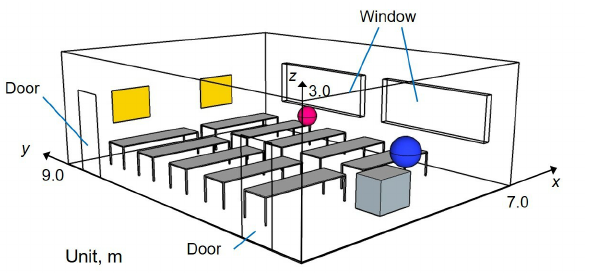
Figure 3. Problem 2 for scalability test: classroom model. Blue and magenta spheres respectively represent the source point and the receiving